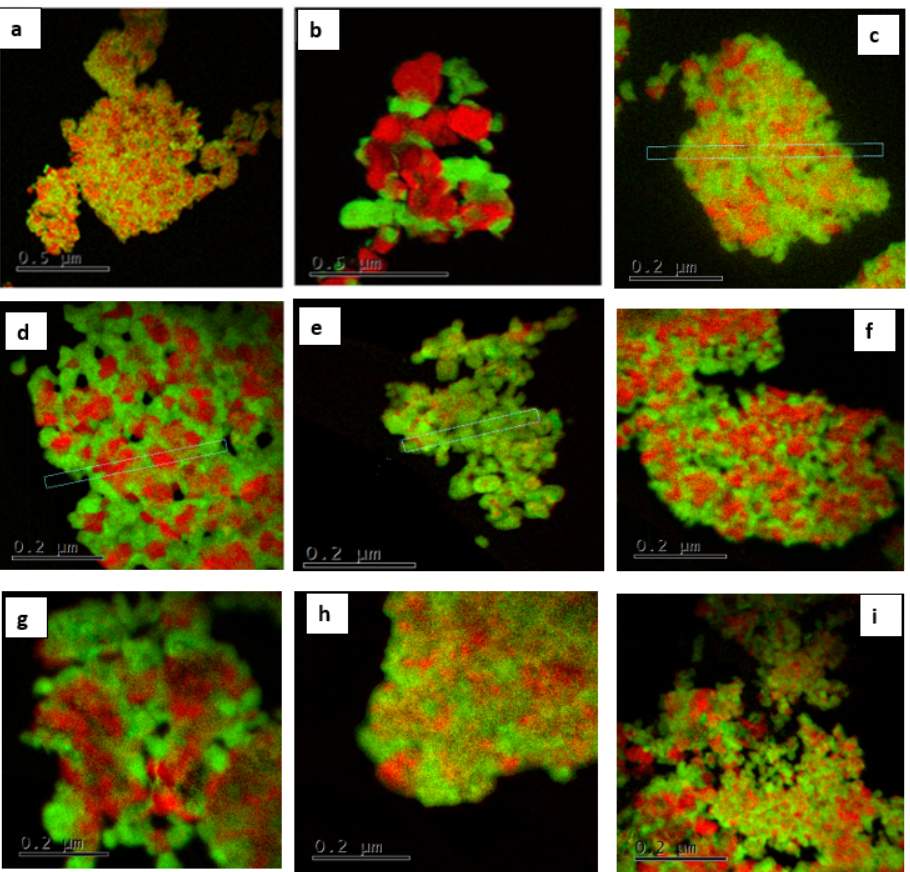
Figure 4. HRTEM-EELS images of Fe 2 O 3 @LSF core-shell materials: ( a ) CS-1; ( b ) CS-2; ( c ) CS-3; ( d ) CS-4; ( e ) CS-5; ( f ) CS-6; ( g ) CS-7; ( h ) CS-8; ( i ) CS-9. La-green; Fe-red.